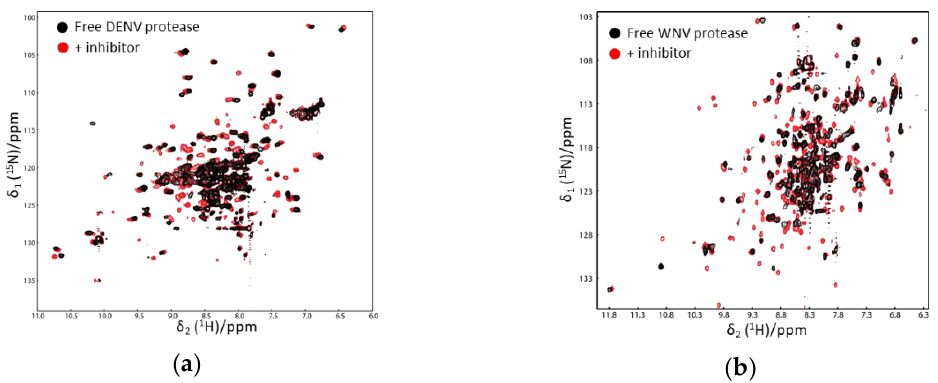
Figure 3. 1 H – 15 N-heteronuclear single quantum coherence (HSQC) spectra of Dengue virus (DENV) ( a ) and WNV protease ( b ) in the absence and presence of an inhibitor. The spectra of free and ligand-bound proteases are shown in black and red, respectively. More cross-peaks were observed when the protease formed a complex with an inhibitor. The spectra were obtained from Reference [58] with slight modifications. Similar results were also obtained in other studies [52,53].